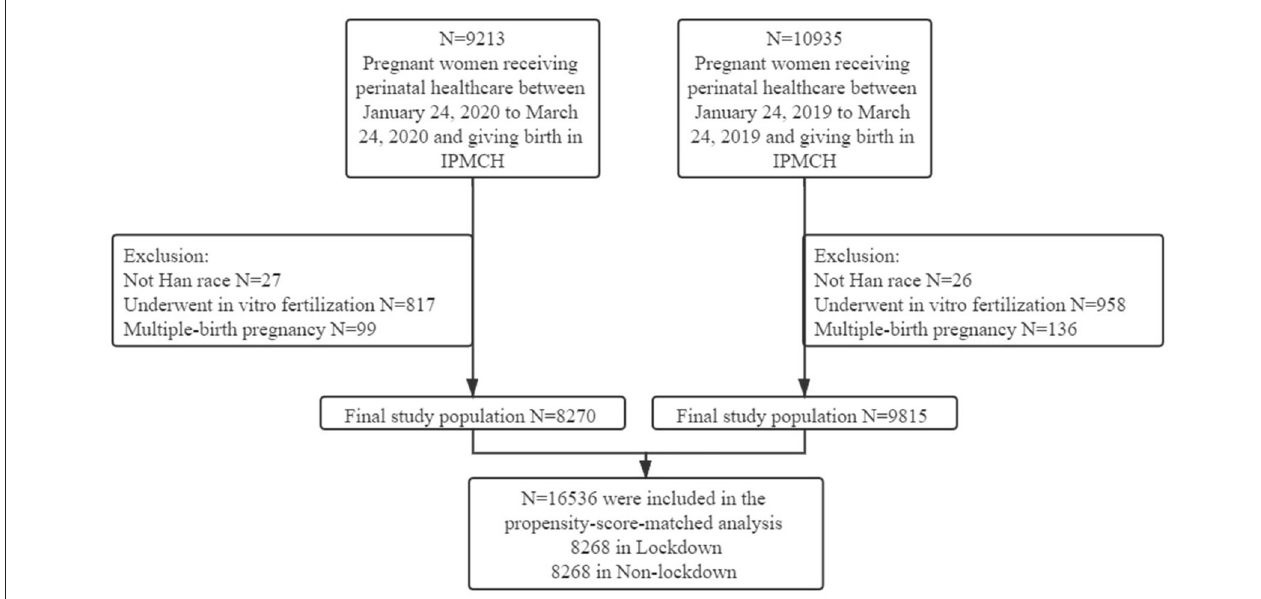
FIGURE 1 | Flow chart of the study